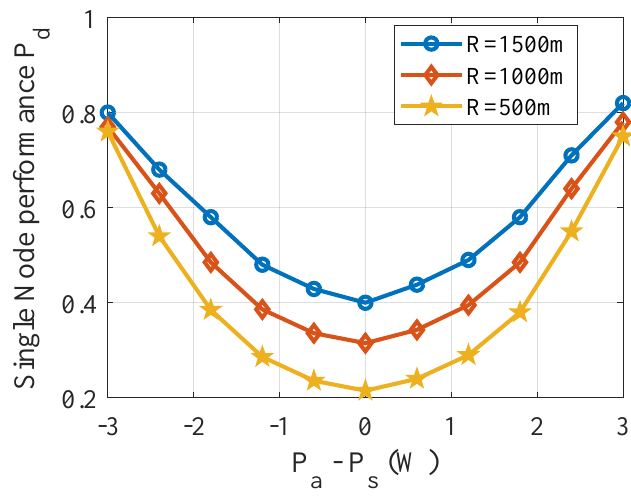
Figure 4. Performance of TPV detection with a single node, which demonstrates that power deviations is the greatest factor.